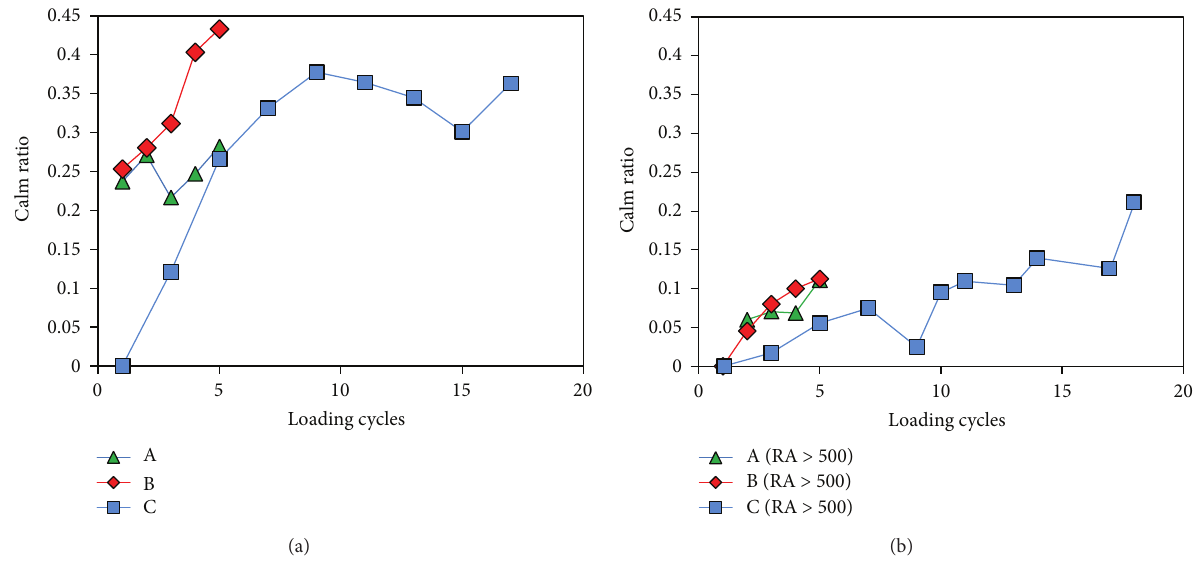
Figure 4: Calm ratio for specimens (A, B, and C) (a) total activity and (b) hits with RA > 500 𝜇